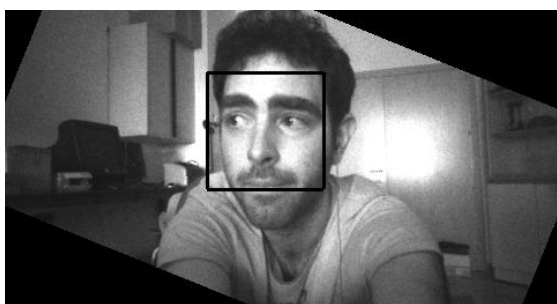
Figure 16. Rotation-invariant face detection. In this example the user (pictured in the image) is holding the EoT and tilting